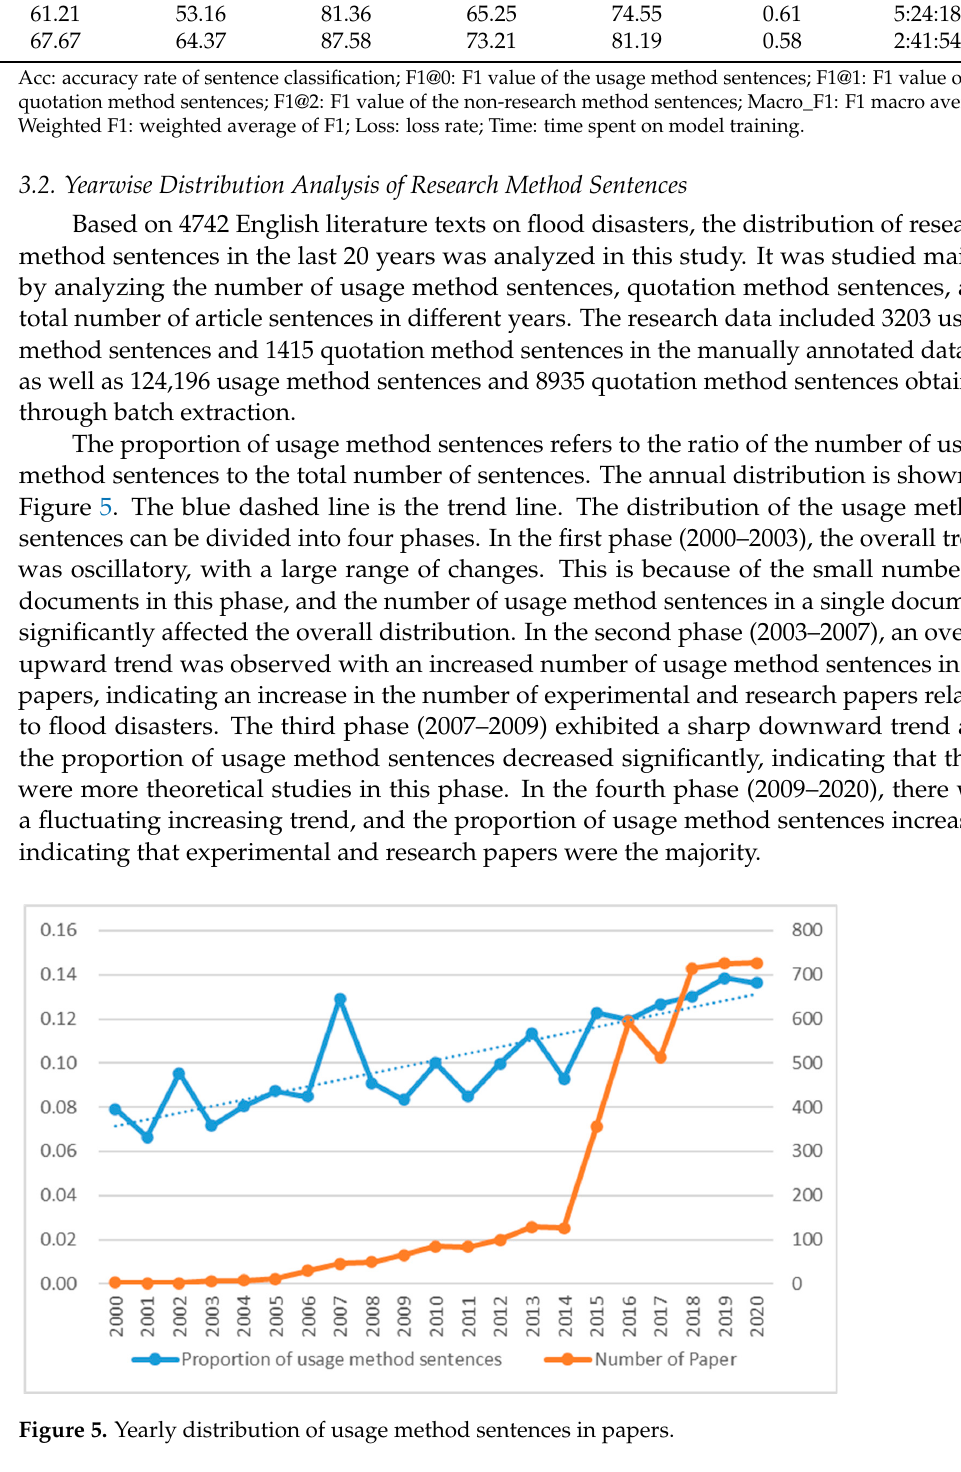
Figure 6. Yearly distribution of quotation method sentences in papers. 4. Discussion 4.1. Comparison of Machine Learning and Deep Learning Methods As described in Table 3, SVM model performed the best among the machine learning methods. This result is consistent with that of Nomponkrang et al. [42], who used decision tree, NB, K-nearest neighbor, and SVM models to classify sentences and concluded that SVM demonstrated a better performance. He et al. [43] combined a single-layer convolu- tional neural network with Bert to determine user intentions based on query sentences. The results revealed that the model significantly improved the accuracy of sentence clas- sification, which is consistent with the conclusion of this study that Bert-CNN was